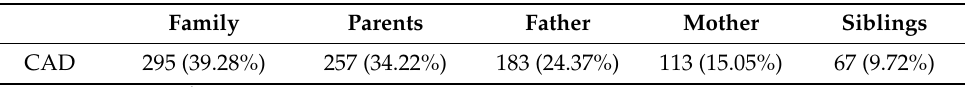
Table 2. Number and percentage of first-degree relatives in a straight line and second-degree relatives in a collateral line who presented with coronary artery disease (CAD). Family Parents Father Mother Siblings CAD 295 (39.28%) 257 (34.22%) 183 (24.37%) 113 (15.05%) 67 (9.72%) CAD, coronary artery disease. Table 3. p -values of associations between the occurrence of CAD and the presence of erectile dysfunction (ED) and IIEF-5 score crude and adjusted for age and education. Family Parents Father Mother Siblings p = 0.0432 p = 0.0210 p = 0.0499 p = 0.6404 p = 0.5774 Erectile dysfunction p = 0.3331 * p = 0.2919 * p = 0.3807 * p = 0.0118 p = 0.0048 p = 0.0176 IIEF-5 p = 0.2870 p = 0.5650 p = 0.0914 * p = 0.0994 * p = 0.2214 * questionnaire score